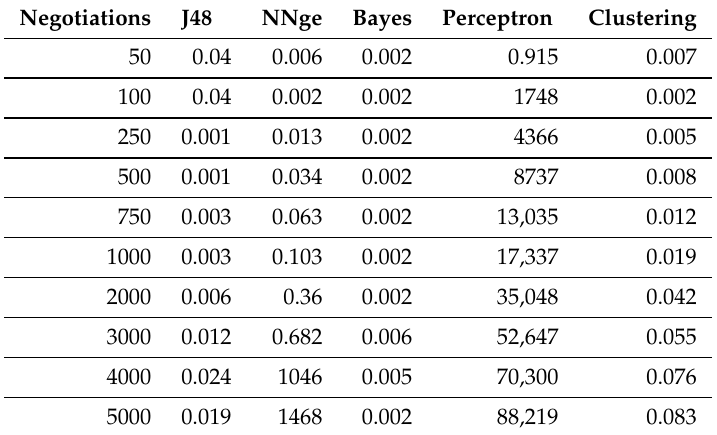
Table 1. Time in seconds required to build protocol outcome models in a laptop Dell xps 13 9343 (Core i5 5200U, 8 GB RAM). Learning algorithms: a decision tree algorithm (J48), a rule